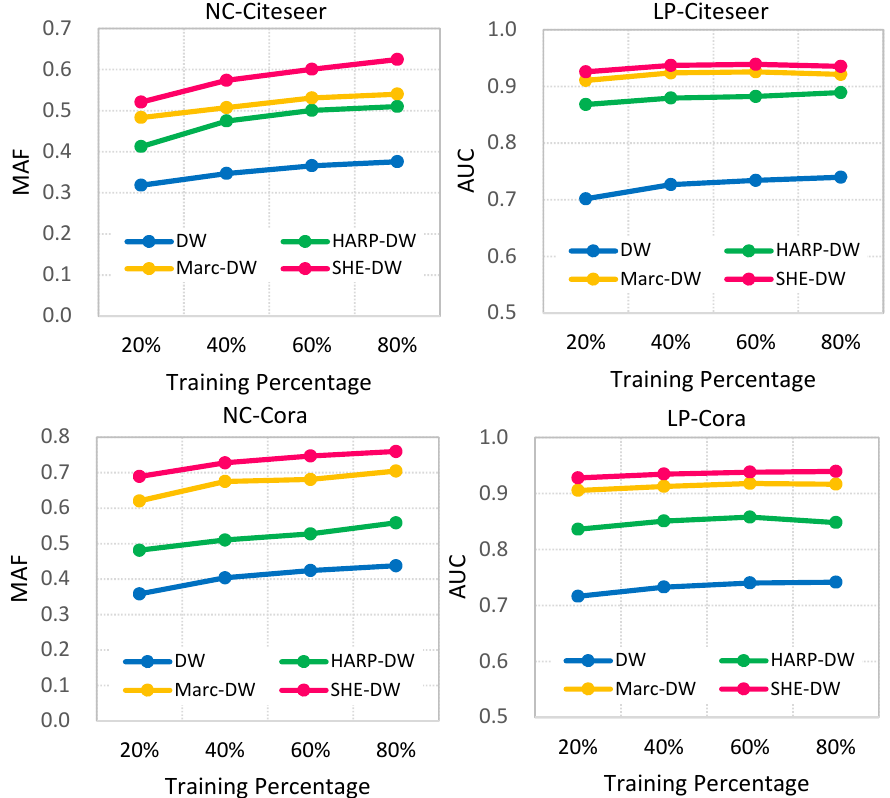
Figure 3. Results on DeepWalk (DW) by varying the training percentage. The left and right columns are on node classification and link prediction, respectively. The top and bottom rows are using Citeseer and Cora datasets,